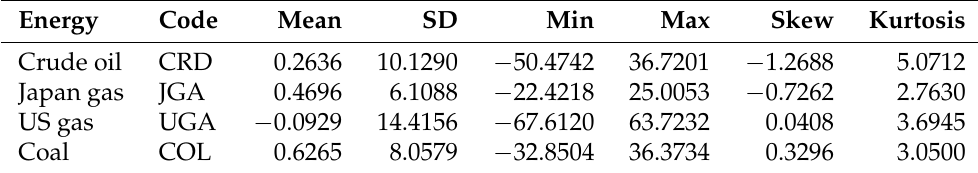
Figure 3. Time plot of energy commodity series of coal, gas and crude oil between years (2005–2021). Table 1. Descriptive statistics of energy assets: crude oil, gas (US gas and Japan Gas) and